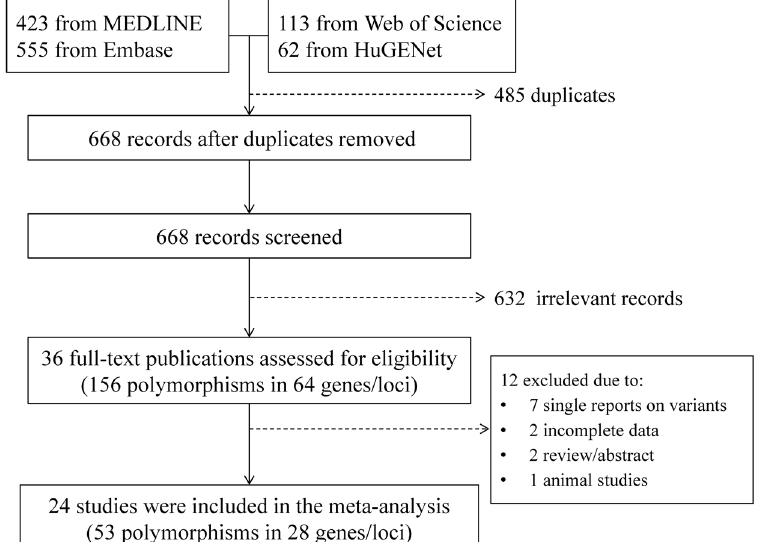
Figure 1. Flow diagram of study selection